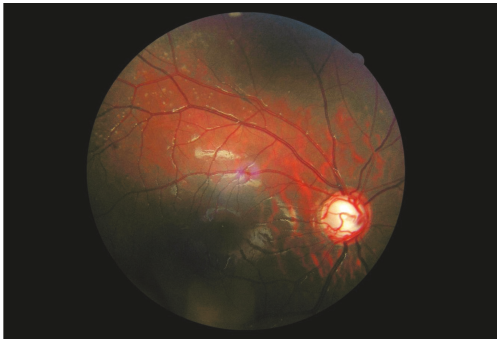
Figure 2: Right eye showing advanced optic disc cupping and glaucomatous looking optic